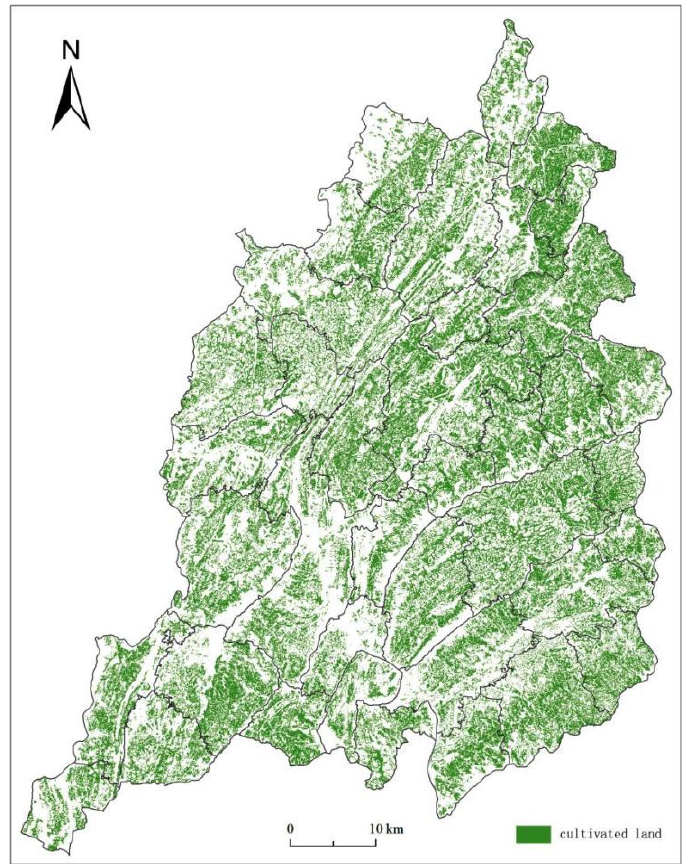
Figure 2. Distribution of cultivated land of study area.